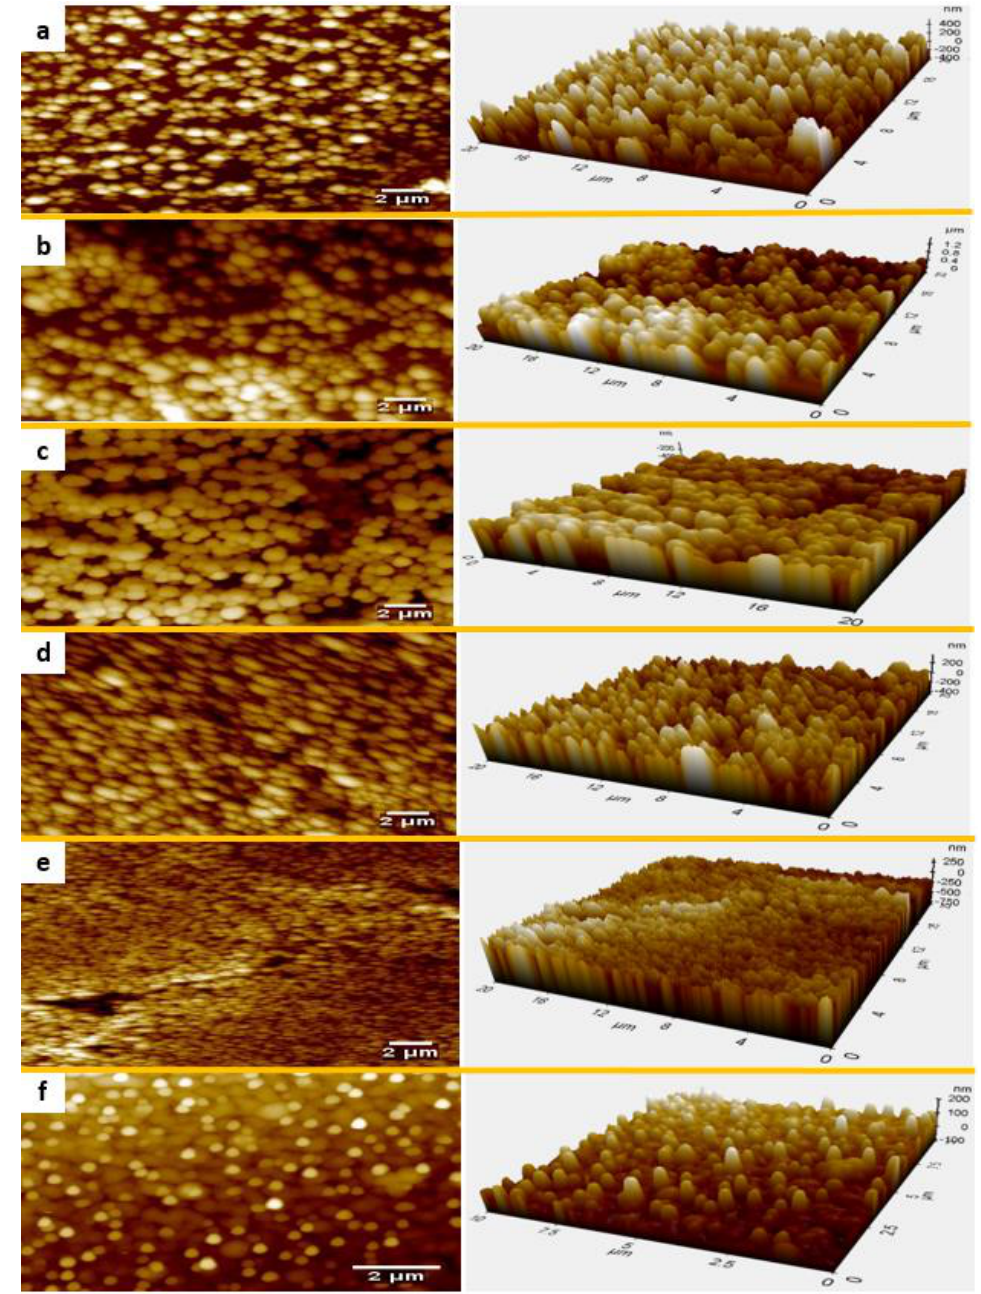
Figure 6. AFM topography of coatings with particle loading (vol. %) of ( a ) 37, ( b ) 53, ( c ) 70, ( d ) 77, ( e ) 84, ( f ) 91.